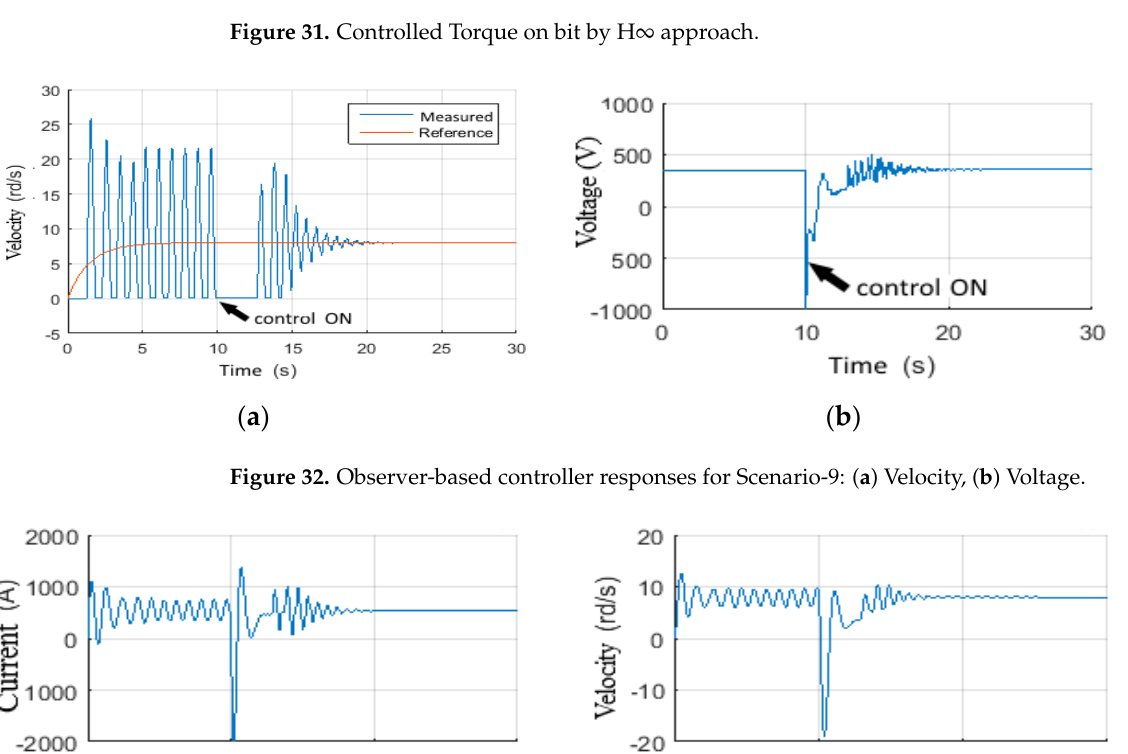
Figure 31. Controlled Torque on bit by H ∞ approach.